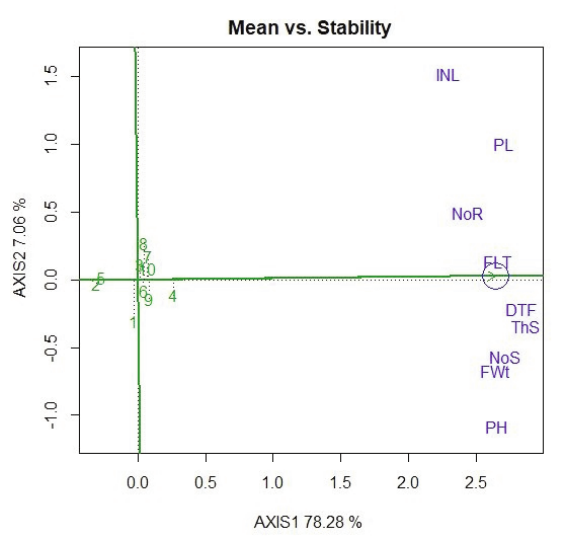
Fig. 3 ­ The average tester coordination view of the genotype by NoF x trait (GYT) biplot ranking the hybrids based on ove­ rall superiority and their strengths and